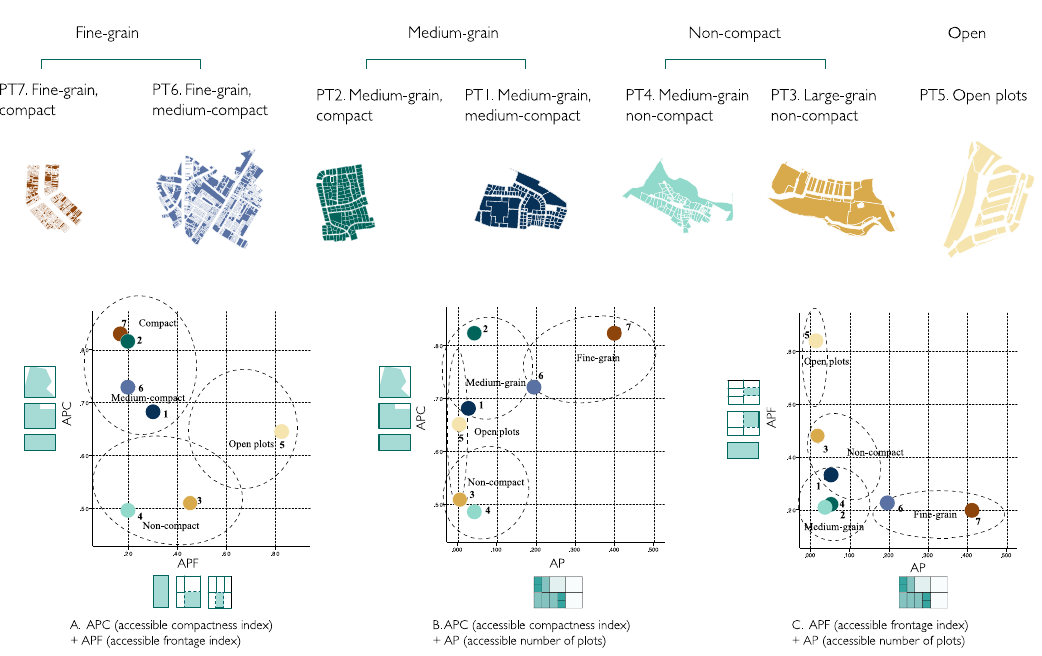
Figure 2. Overview of the plot types and three scatterplots with numeric parameters of each type, based on three plot measures: accessible number of plots (AP), accessible compactness index (APC), and accessible frontage index (APF).